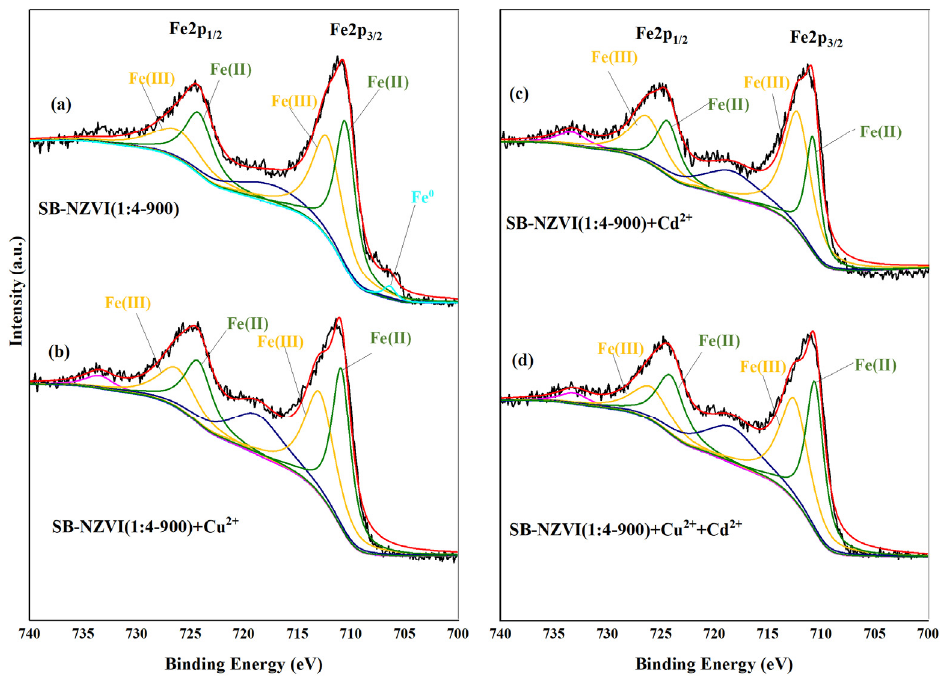
Figure 5. Fe 2p narrow scan spectra of SB-NZVI(1:4-900) ( a ) and after a reaction with Cu 2+ ( b ), Cd 2+ ( c ), and coexisting with two heavy metals ( d ).